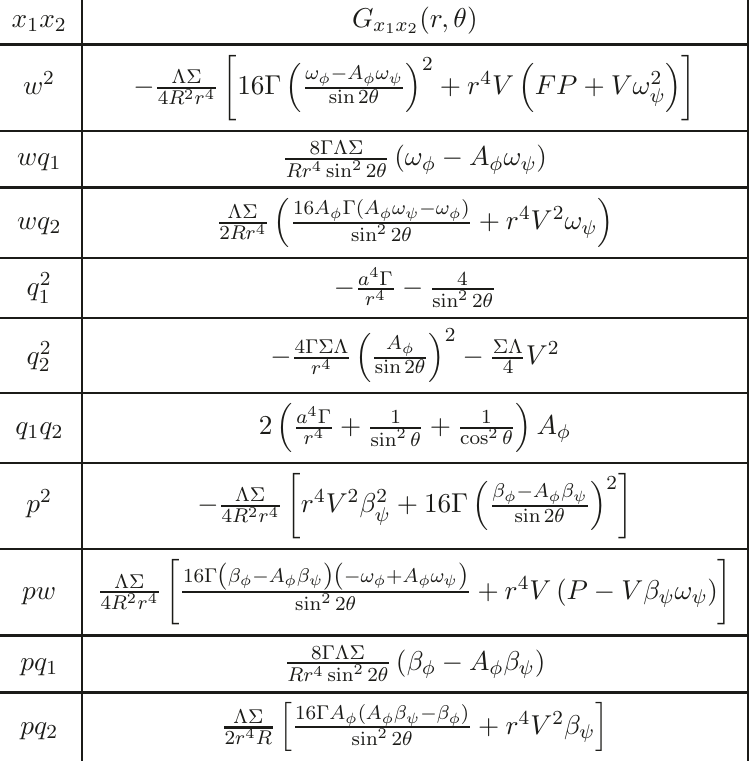
Table 1 . G x ( r, θ ) for superstrata with data satisfying (5.1) and (5.2). 1 x 2